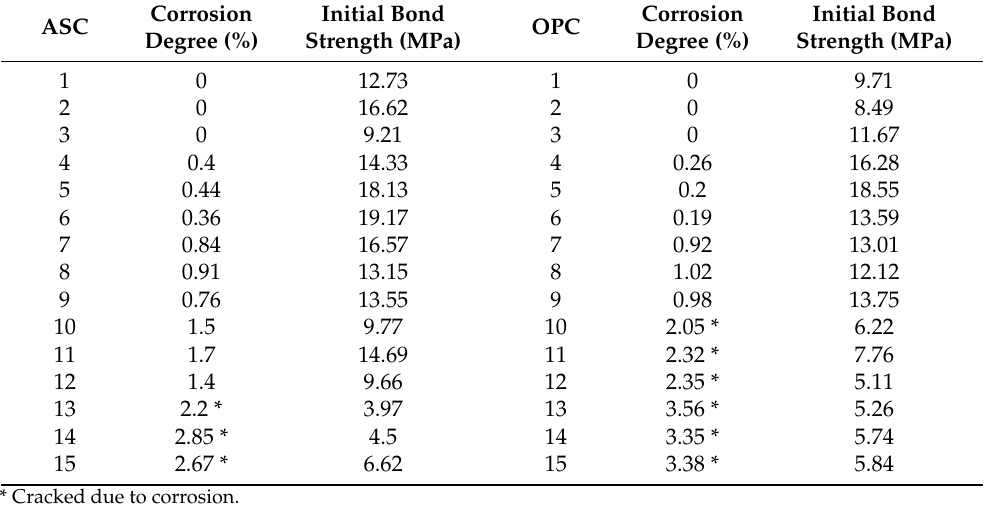
Table 8. Corrosion degree and initial bond strength.